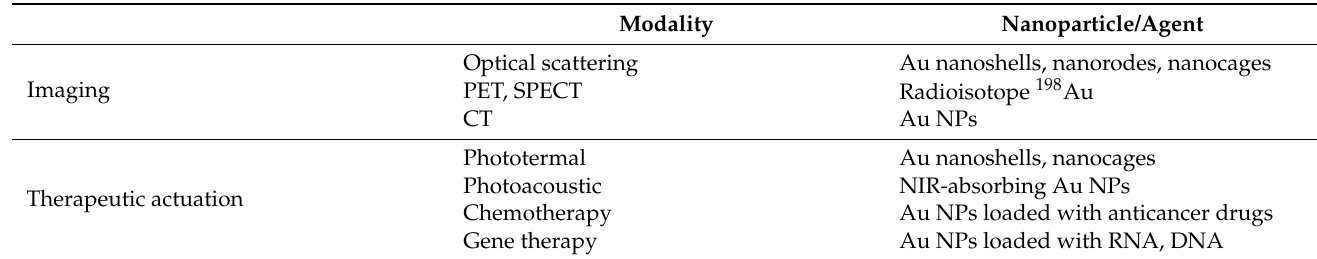
Table 2. Imaging and biomedical capabilities of Au NPs